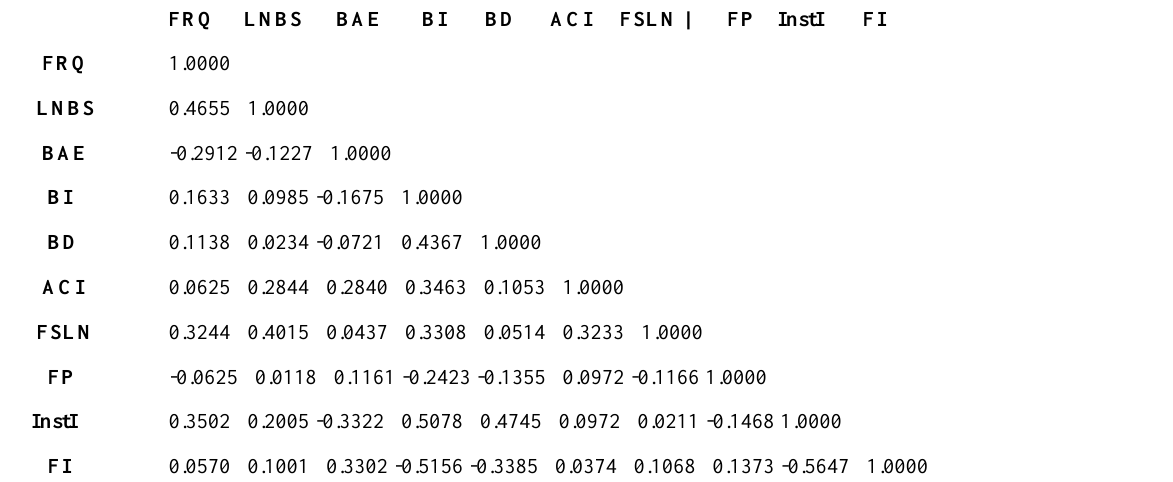
Table 3: Pearson’s Correlation results among Independent Variables